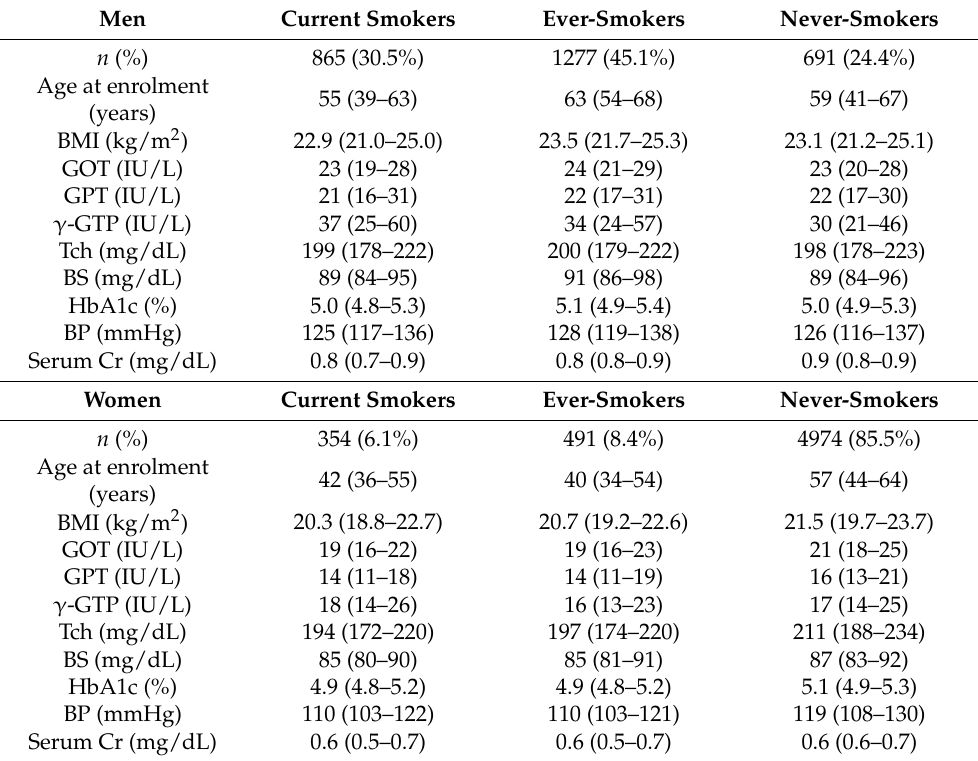
Table 1. Demographic background and indices of noncommunicable